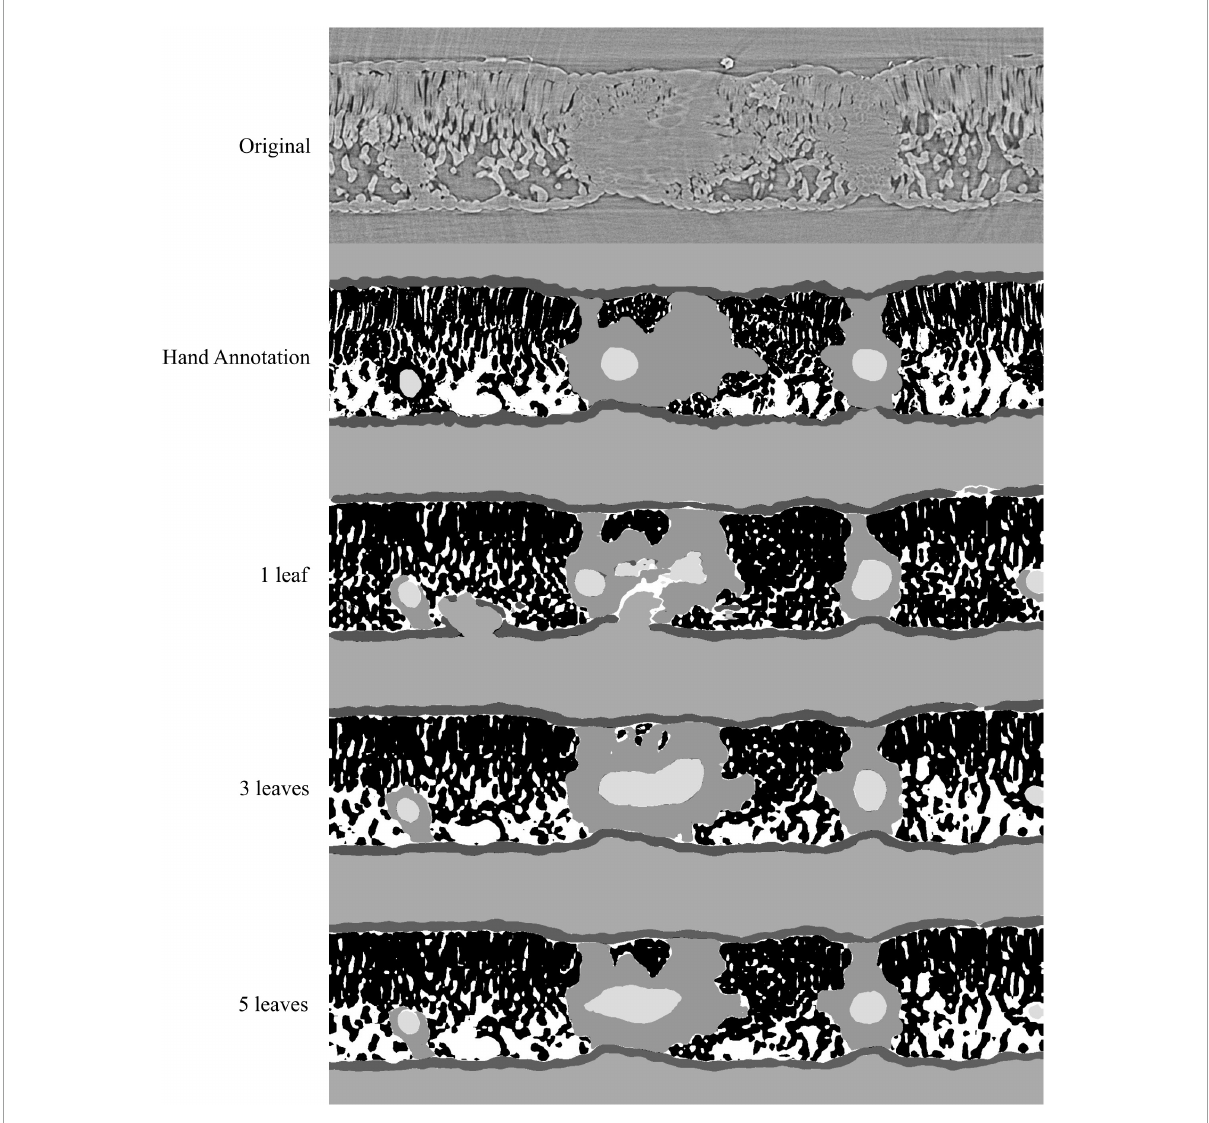
FIGURE3 Visual representation of the model outputs for a single walnut leaf image; top image is a X-ray CT scan taken from a leaf that was not used for training or validation of the applied models; next is the hand annotated image of the scan followed by the outputs from the best performing model trained on 1, 3, and 5 leaves, respectively. For the walnut leaf segmentations the background is light gray, the epidermis is dark gray, the mesophyll is black, the air space is white, the bundle sheath extensions are middle gray, and the veins are lightest